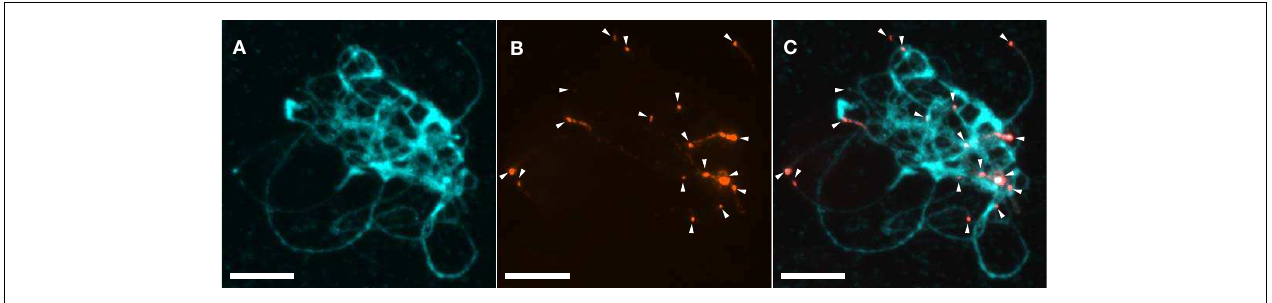
are in red, and chromosomes in blue in (A) and (C) .The 17 chromosome termini with khipu signals are indicated by white arrowheads. Bars = 10mm.